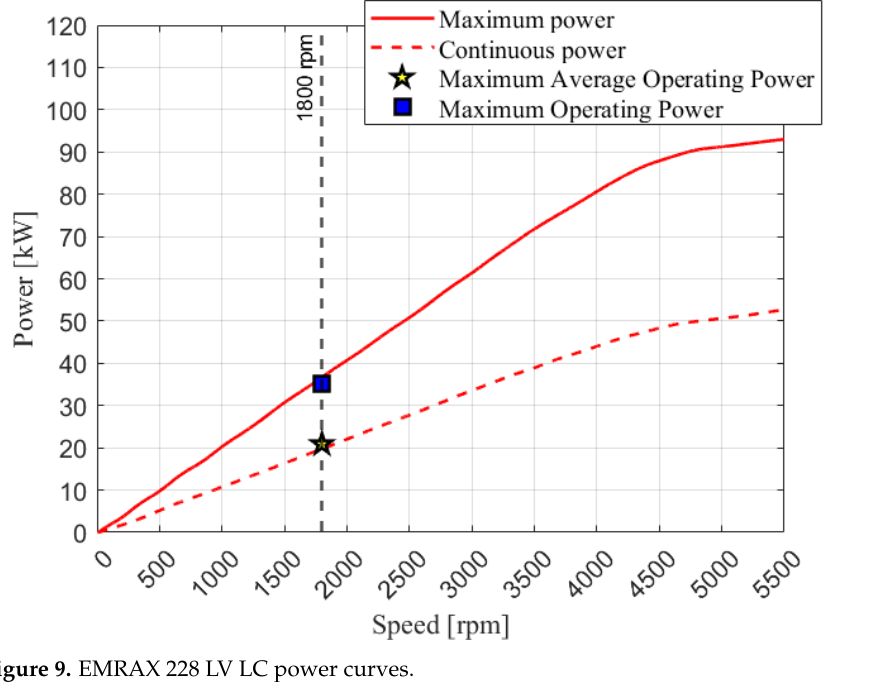
Figure 9. EMRAX 228 LV LC power curves.